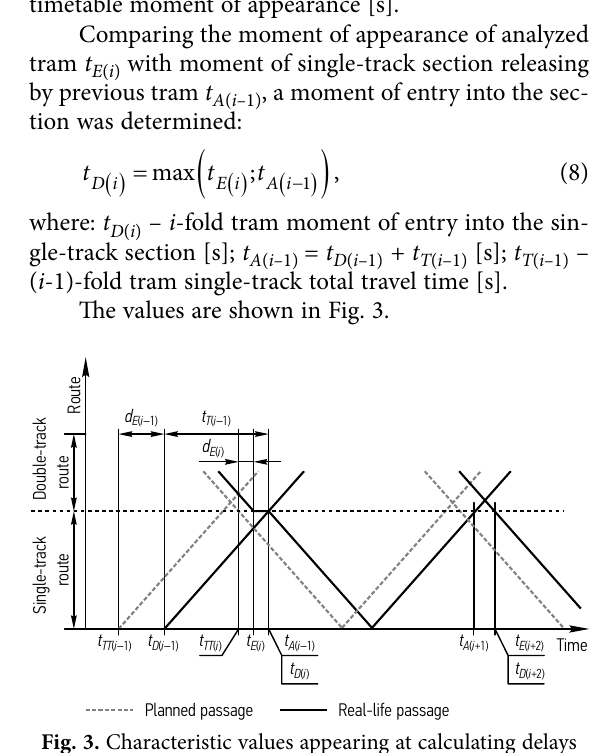
Fig. 3. Characteristic values appearing at calculating delays between trams at single-track route section